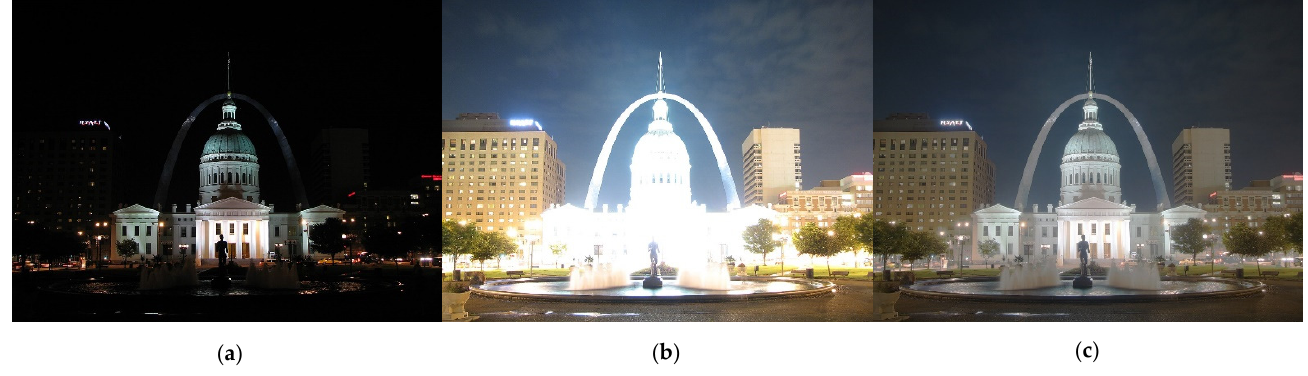
Figure 1. Multiple exposure source images and fusion image: ( a ) under-exposed image, ( b ) over- exposed image, and ( c ) fused image by DenseFuse [7].